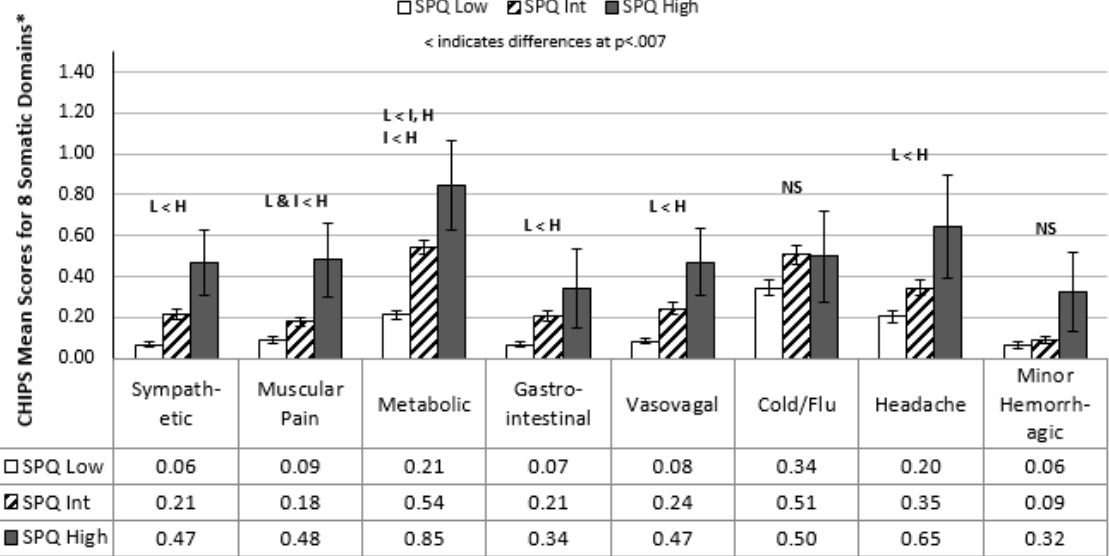
Figure 1. Somatic Symptom Comparisons across Low, Intermediate, and High Schizotypy Scores (Mean/Std. Error). * CHIPS = Cohen-Hoberman Inventory of Physical Symptoms [56] somatic domains [57]. Permission for use of scales is not necessary when use is for nonprofit academic research or nonprofit educational purposes. https://www.cmu.edu/die-